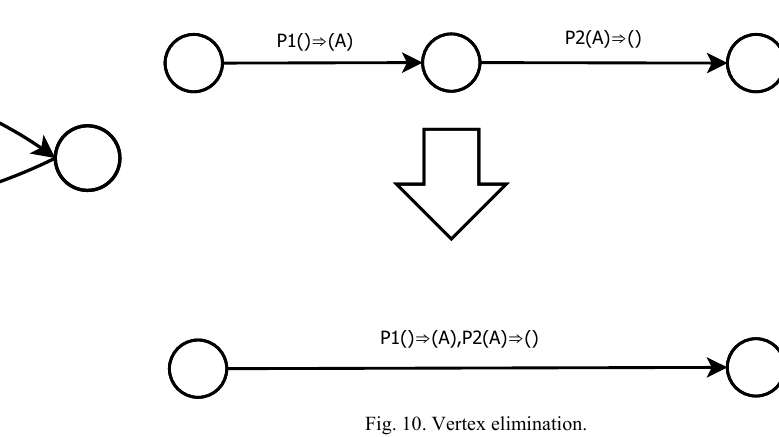
Fig. 10. Vertex elimination.